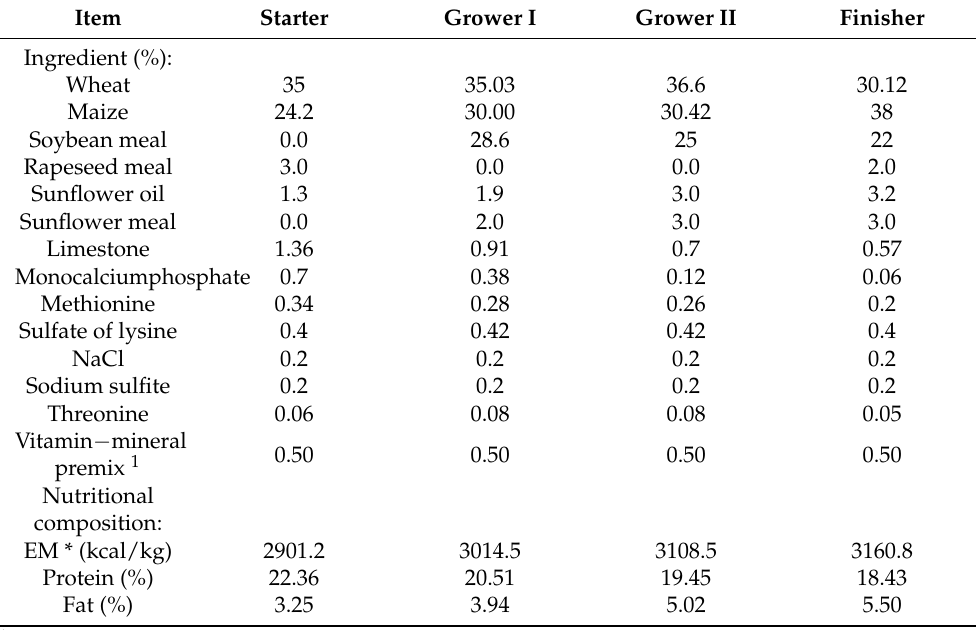
Table 1. Formulation and nutritional composition of the chickens’